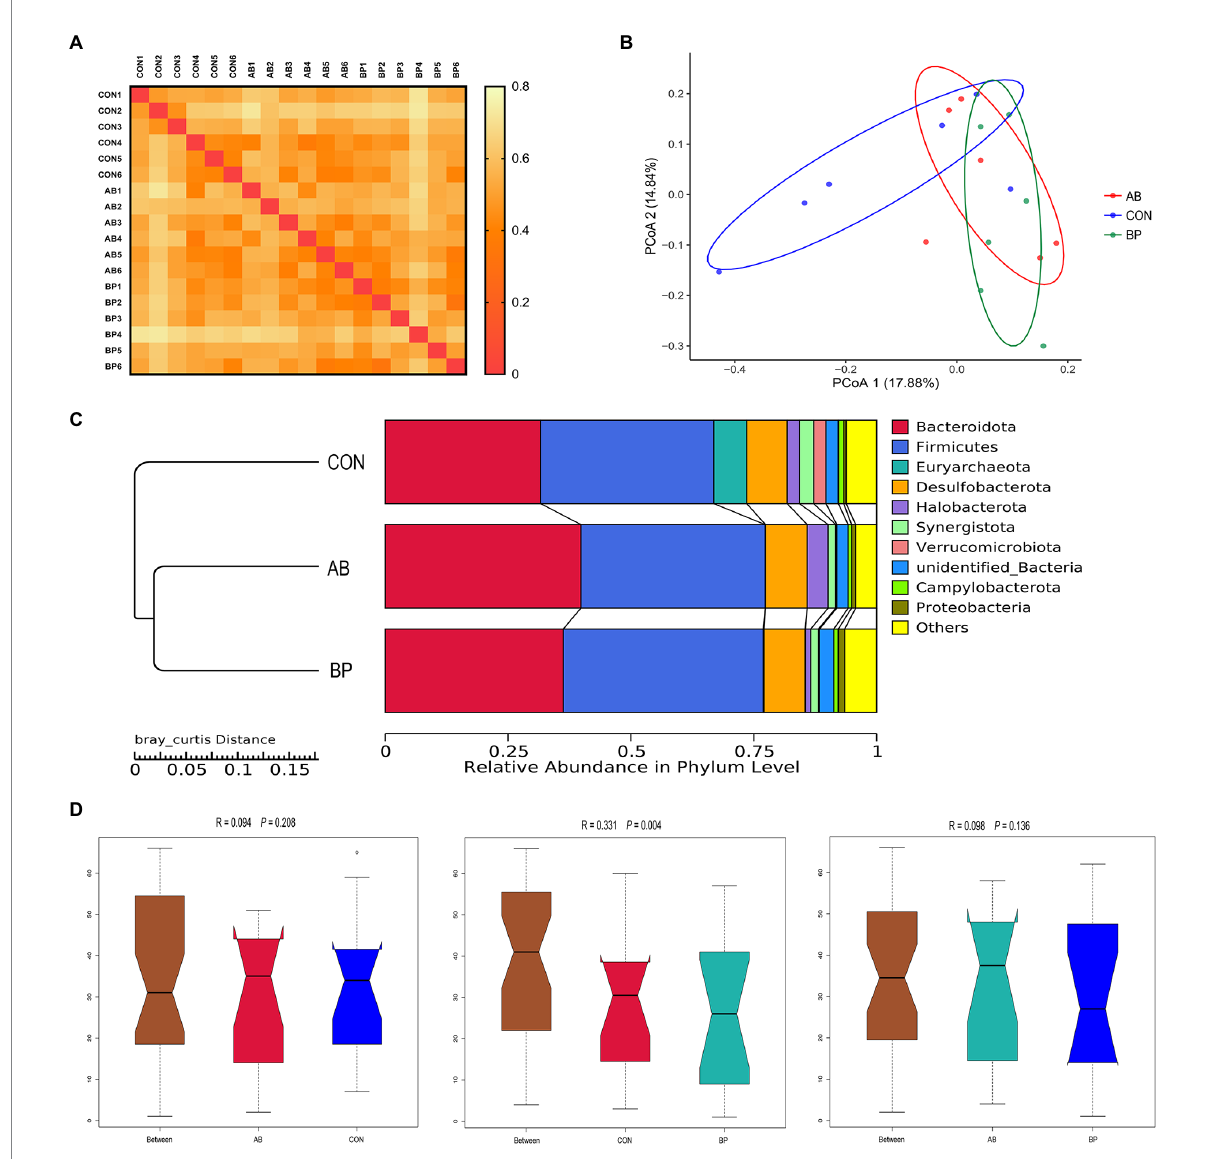
FIGURE 12 Beta diversity analysis of cecal community. (A) The results of the heat map drawn using bray_curtis distance matrix; (B) The principal coordinate analysis (PCoA); (C) Unweighted pair-group method with arithmetic mean (UPGMA) phylogenetic tree; and (D) The analysis of ANOSIM. CON group, broiler chickens fed a basal diet; AB group, broiler chickens fed a basal diet supplemented with 50 mg/kg aureomycin; BP group, broiler chickens fed a basal diet supplemented with 40 mg/kg Bopu powder containing protopine and allocryptopine. n = 6. Differences between groups were considered significant at p <